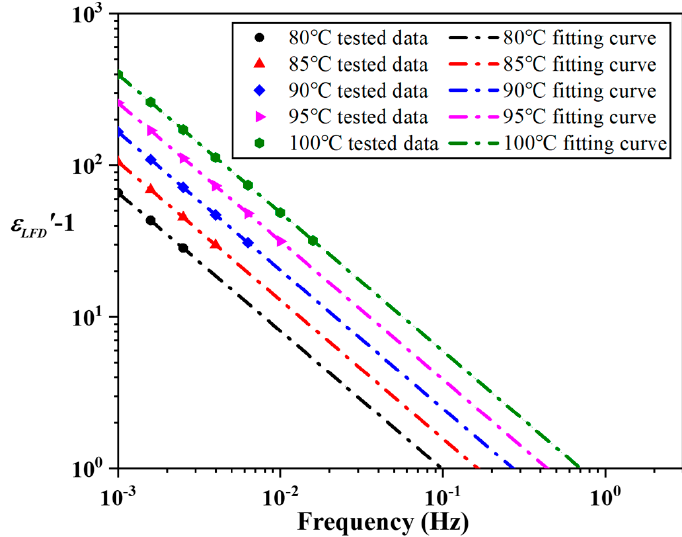
Figure 7. Extraction and fitting of real permittivity data related to the low-frequency dispersion (LFD) process.